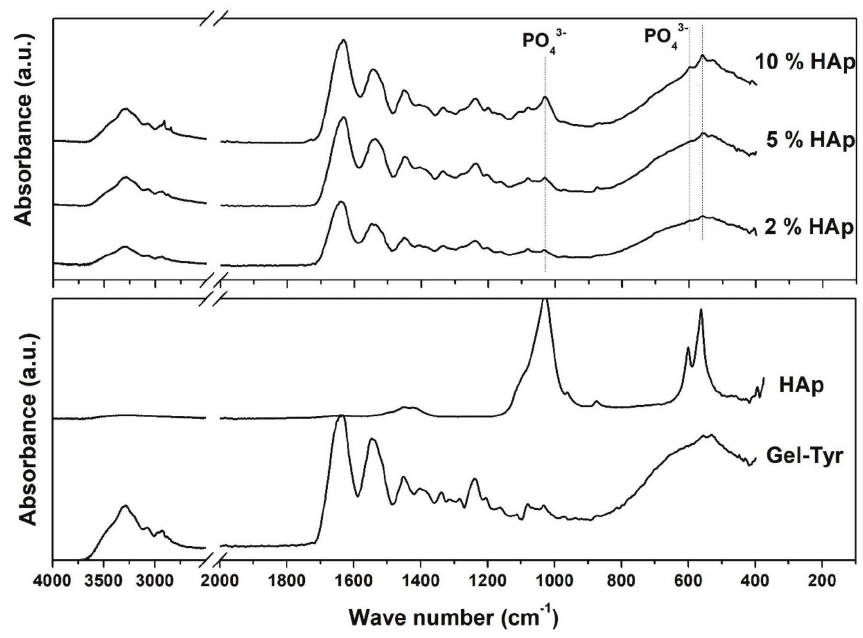
Fig. 2 – FTIR spectra of gelatine-tyramine (Gel-Tyr), hydroxyapatite (HAp) and Gel-Tyr/ HAp composites with different HAp content (2 % HAp, 5 % HAp, and 10 % HAp)